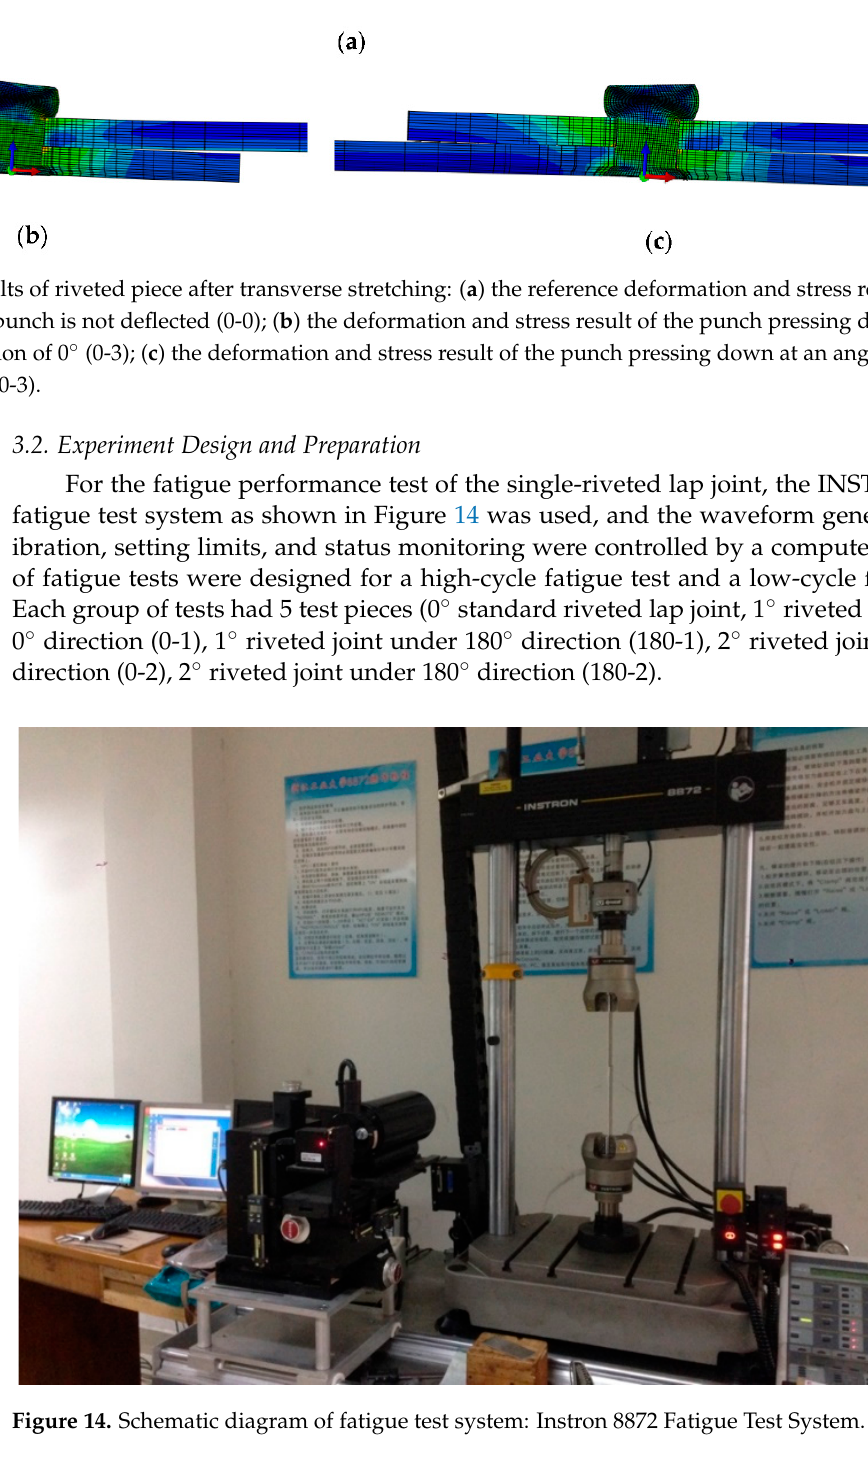
( b ) Figure 15. High-cycle and low-cycle fatigue test results of riveted lap joints: ( a ) plate fractures with high-cycle fatigue failure; ( b ) rivet fracture with low-cycle fatigue failure.